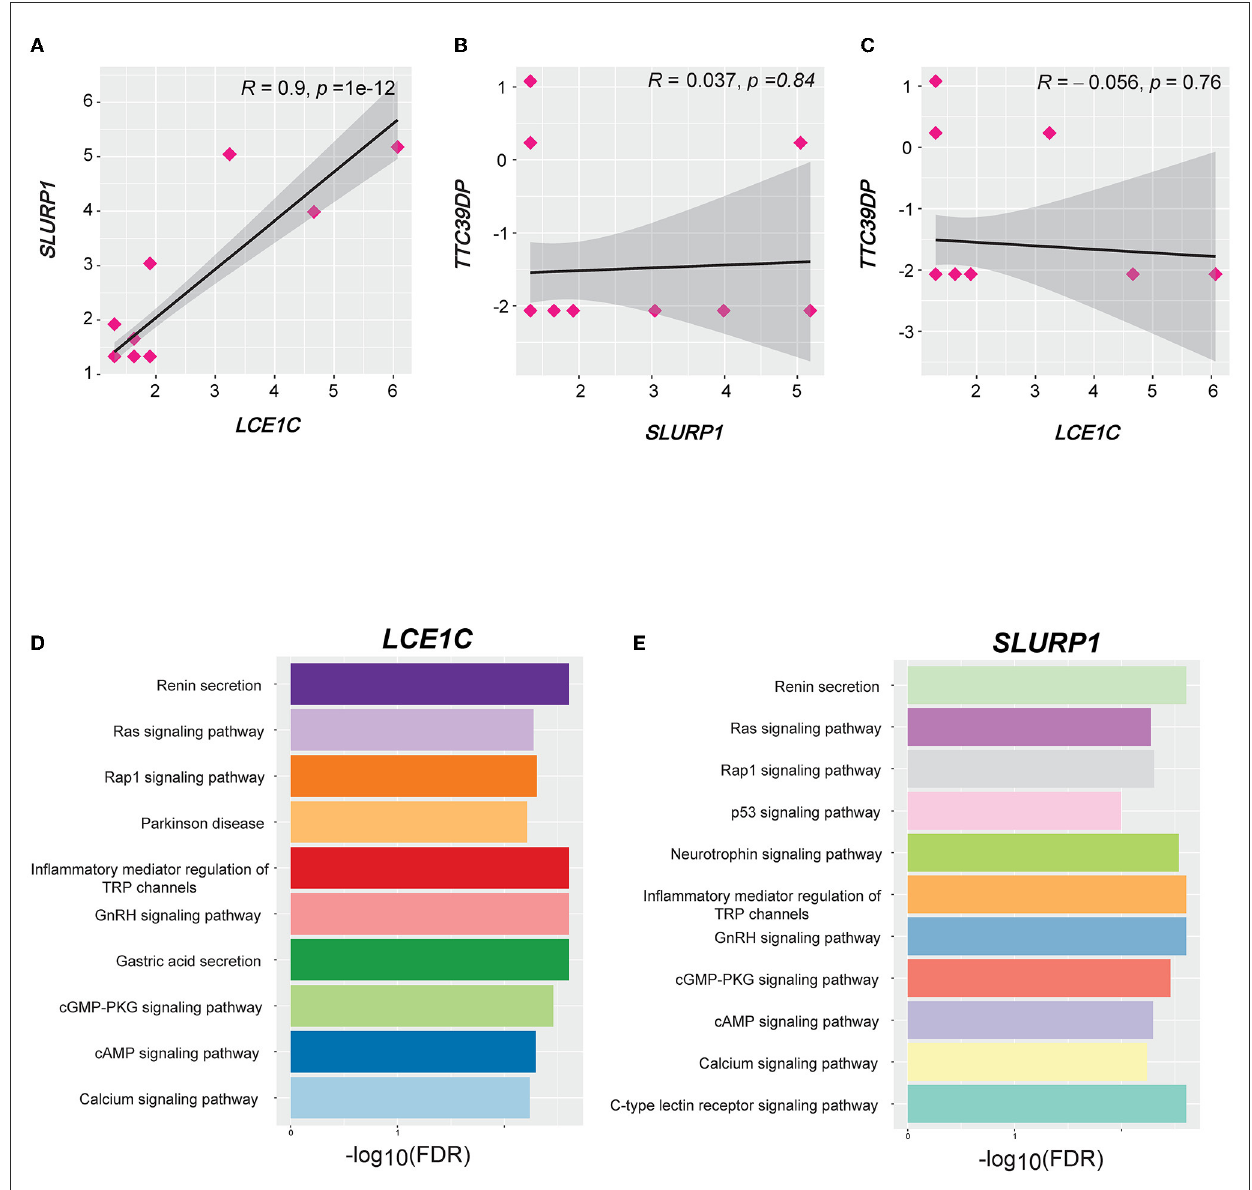
FIGURE6 Correlation and pathways associated with LCE1C , SLURP1 , and TTC39DP expression levels. (A) Correlation between LCE1C and SLURP1 expression levels. (B) Correlation between TTC39DP with SLURP1 and (C) LCE1C expression levels. Pearson’s correlation coefficients ( R ) and P -values are shown. (D) The KEGG pathways enriched with LCE1C and (E) SLURP1 highly correlated genes ( R > 0.5) were identified by GSEA